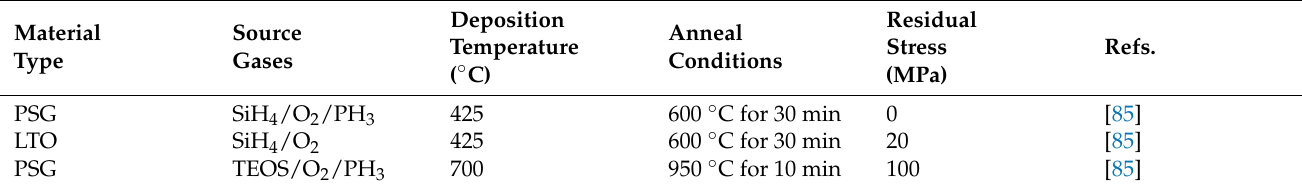
Table 22. Resultant residual stresses in annealed SiO 2 thin-films deposited using LPCVD.